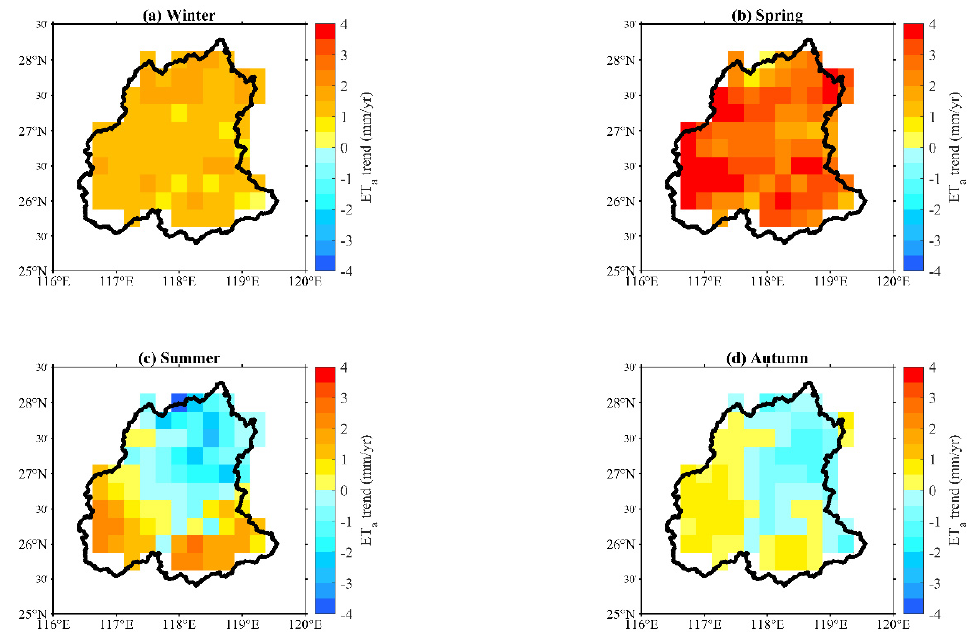
Figure 5. Seasonal trends of ET a in the MRB in ( a ) winter, ( b ) spring, ( c ) summer and ( d ) autumn from 2000–2019, and grid at 0.25°×0.25°.